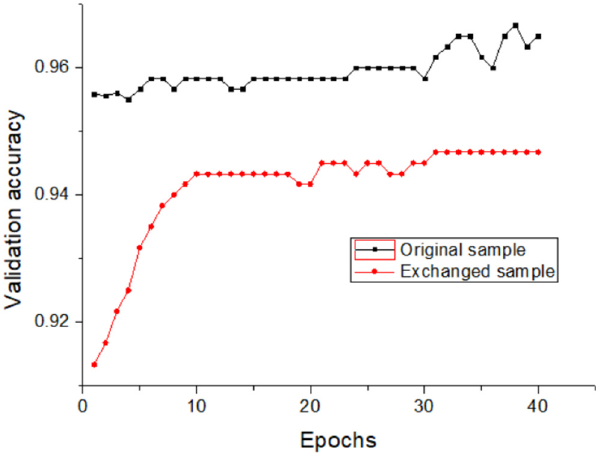
Figure 8. Validation accuracy in two types of data (VGG16, dual-input). Table 4. Validation accuracy in three penetration states (VGG16, dual-input, exchanged data).